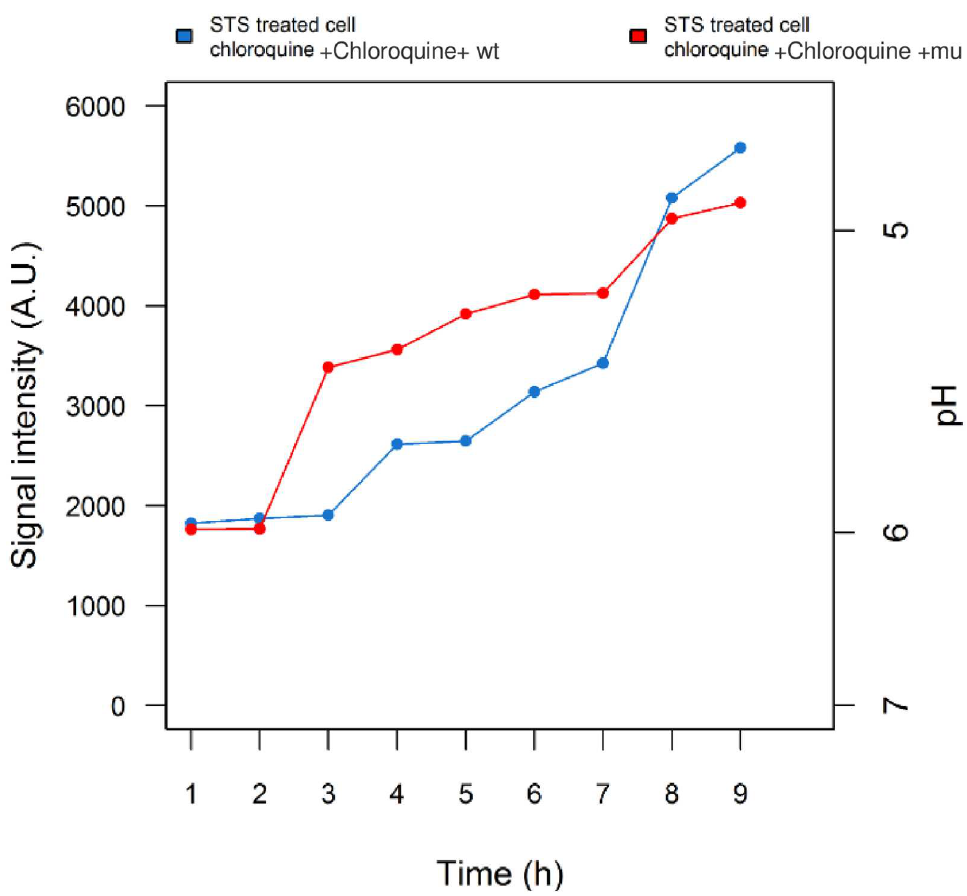
Fig 5. Effects of chloroquine treatment and phagosomal acidification on A . fumigatus infection in an apoptotic cell. The acidifiedpH of the apoptoticcell in the presence of chloroquine was maintainedafter infection. As it can be concluded, A . fumigatus only interferes with pH if the phagolysosme stays